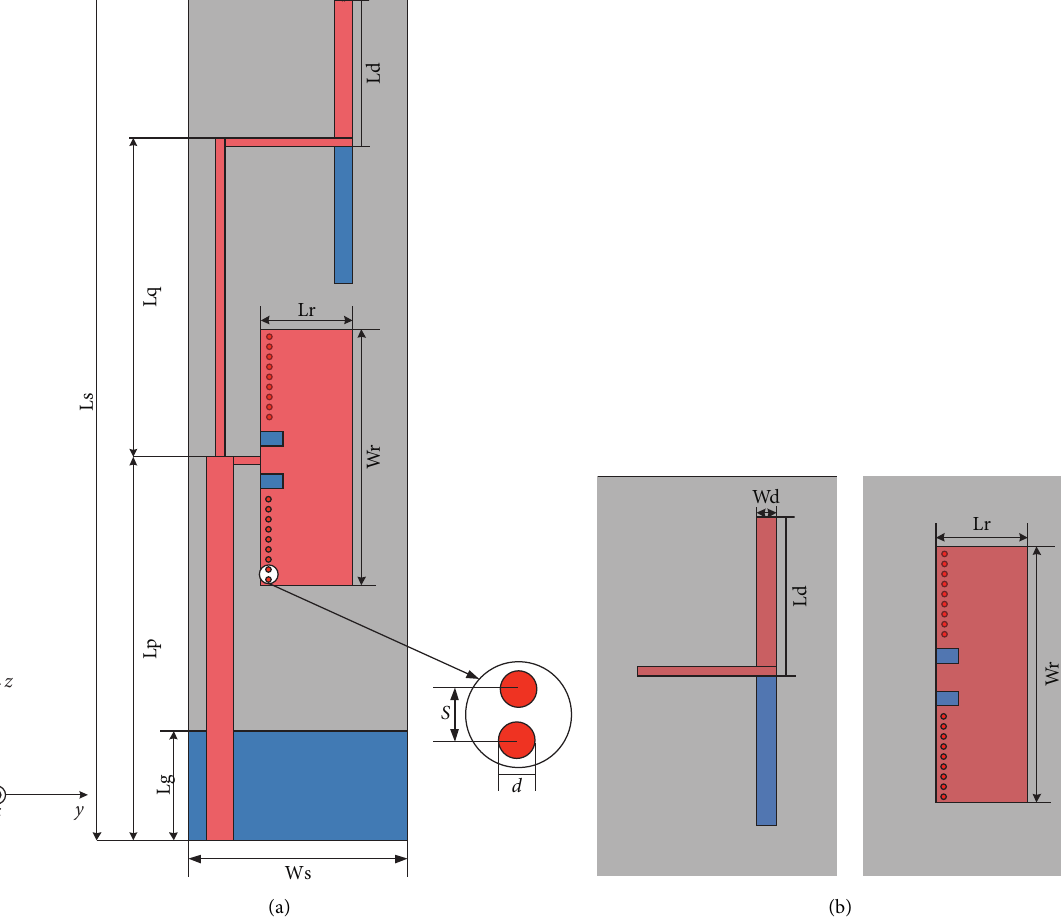
Figure 2: Configuration of the proposed antenna: (a) the top patch and (b) the printed dipole patch and the rectangular patch.